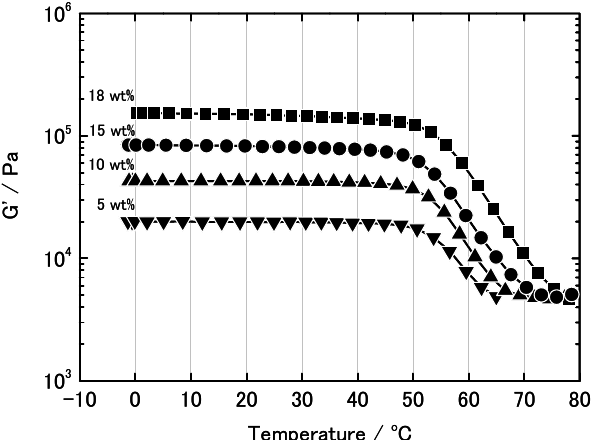
Figure 7 Temperature dependence of PVA-H obtained by using P17F with various C